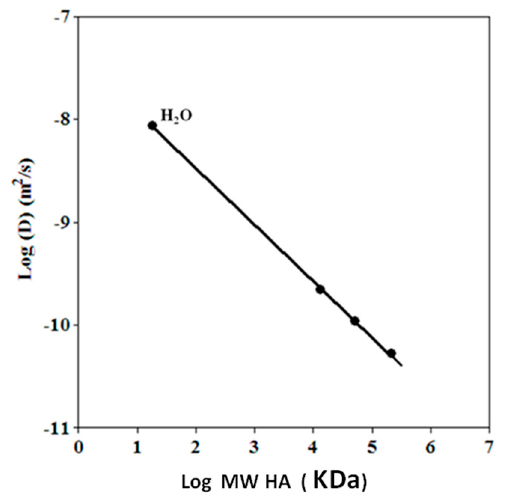
Figure 5. Calibration curve of the di ff usion coe ffi cient of fragments of HA with di ff erent MWs: 13 kDa; 50 kDa; 208 kDa. The di ff usion of the trace of protonated water molecule (1% in D 2 O) is also included with a correlation of 0.999.